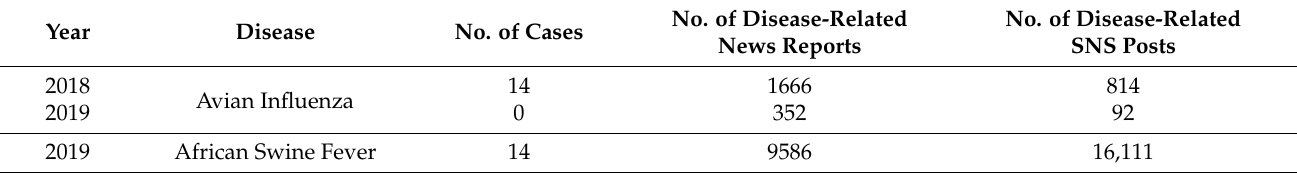
Figure 2. Trends of retail chicken prices, Avian Influenza (AI)-related news and SNS frequencies in 2018 and 2019. The x axis indicates time and the y axis indicates retail chicken price and frequency. Table 1. List of Unstructured Data Used in this